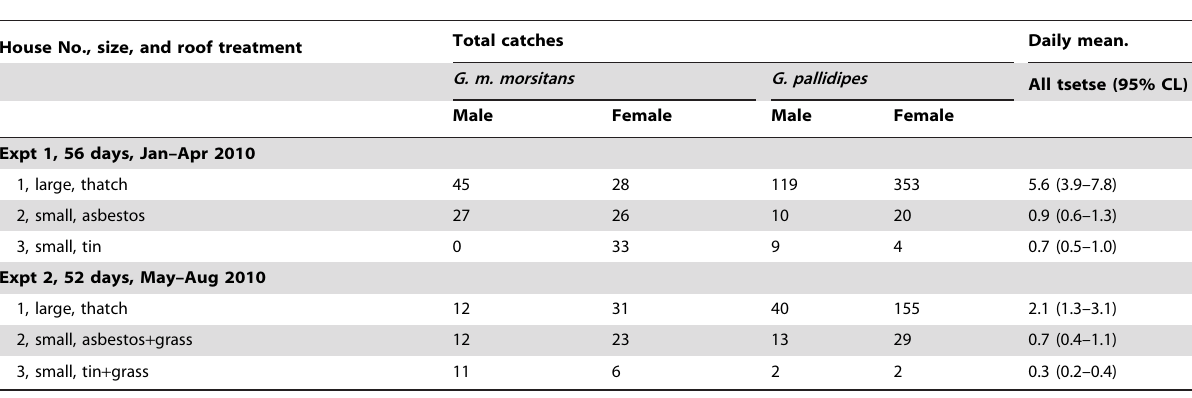
Table 2. Catches from various houses with distinctive roofs, in two experiments.